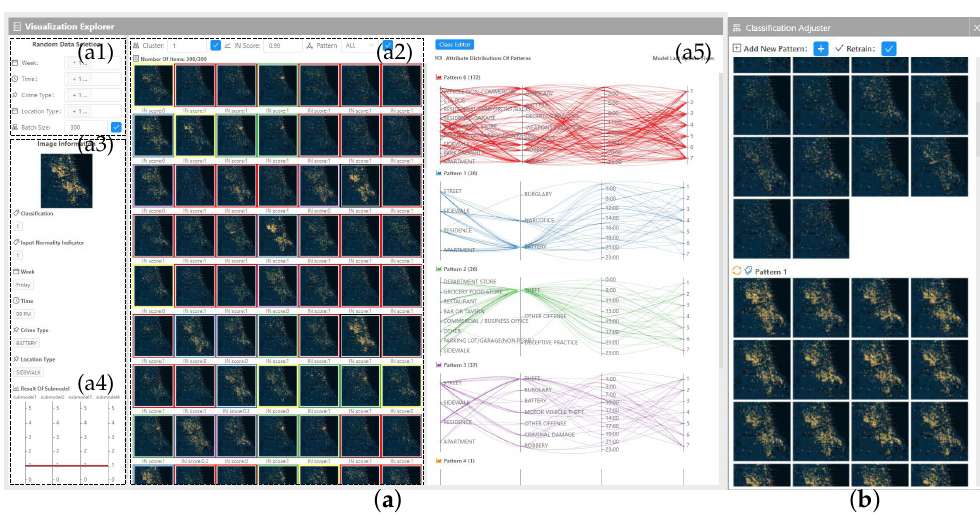
Figure 9. The interface of the proof-of-concept tool that integrates two components, i.e., ( a ) the visualization explorer and ( b ) the classification adjuster. (a1–a5) are the five sub-views of ( a